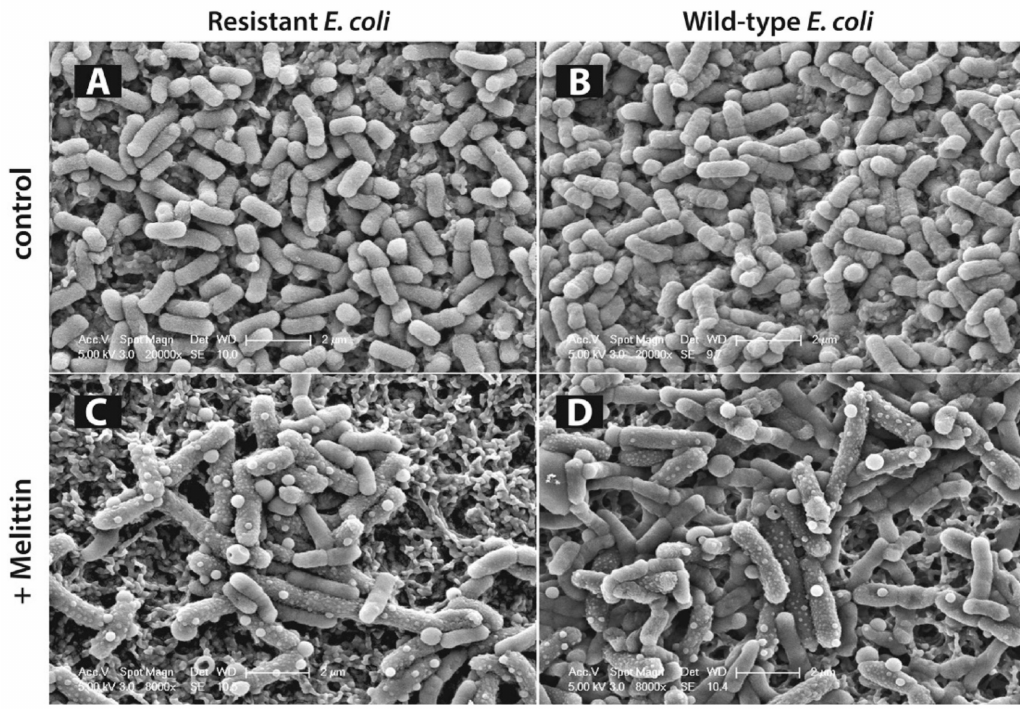
Figure 6. Scanning electron microscopy (SEM) imaging of antibiotic resistant and wild-type Escherichia coli ( E. coli ) cells on membrane filters. Antibiotic resistant E. coli cells in absence of any drugs ( A ), treated with minimum inhibitory concentration (MIC) of melittin ( C ), wild-type E. coli cells in absence of any drugs ( B ), treated with MIC of melittin ( D ) (reproduced with permission from a previous paper